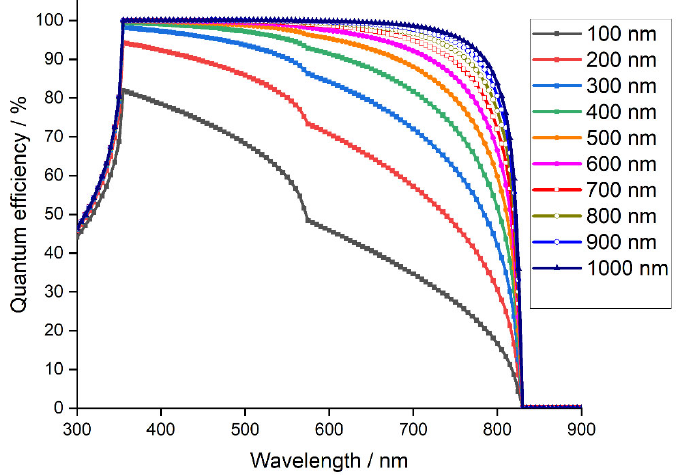
Figure 6. Quantum efficiency of the simulated device with absorber layer thickness.